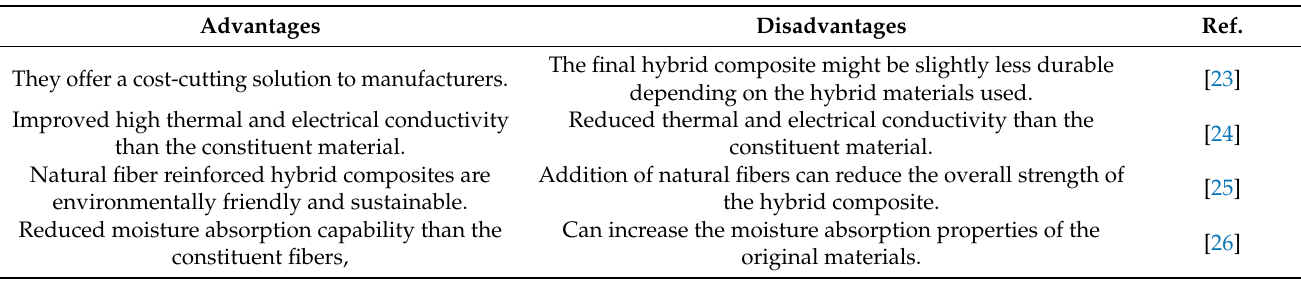
Table 1. Advantages and disadvantages of hybrid composites.